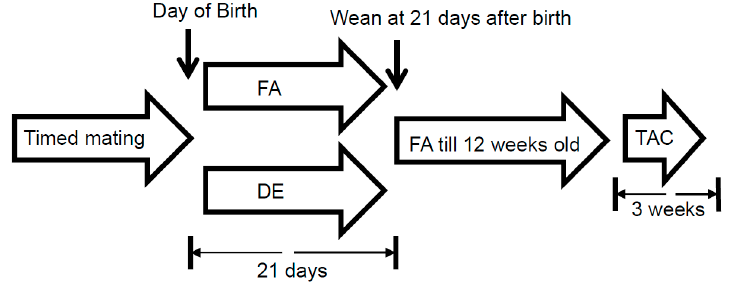
Figure 1. Schematic diagram of the neonatal diesel exhaust particulate exposure protocol. FA: filtered air; DE: diesel exhaust; and TAC: transverse aortic constriction. air; DE: diesel exhaust; and TAC: transverse aortic